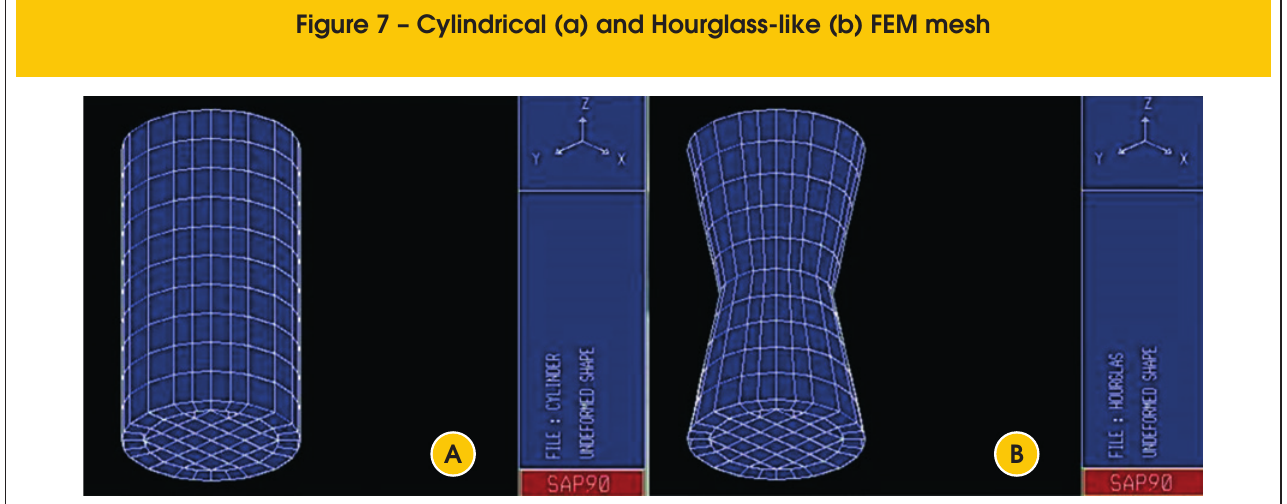
On the top and bottom of the samples, the joint horizontal displacements were restricted. On the bottom, even vertical displacements were restricted. In all the other nodes, all 6 de- grees of freedom were released. This procedure allows the Poisson’s effect, which is compatible with the actual testing of compressive strength, practiced in laboratories.